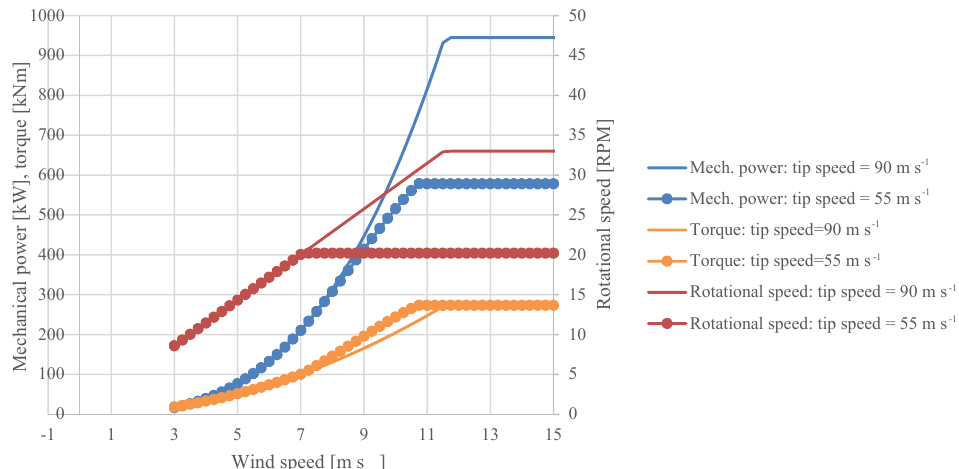
Figure 12. Mechanical power, rotational speed and main shaft torque as functions of wind speed for control of the rotor with maximum tip speeds of 90 and 55ms − 1 . Table 4. Calculation of the expected lifetime of the blade leading edge with no reduction in the tip speed. Control Strategy 1. Rain Droplet Percent of Hours per Blade tip Time to LE Fraction of life intensity size time year speed